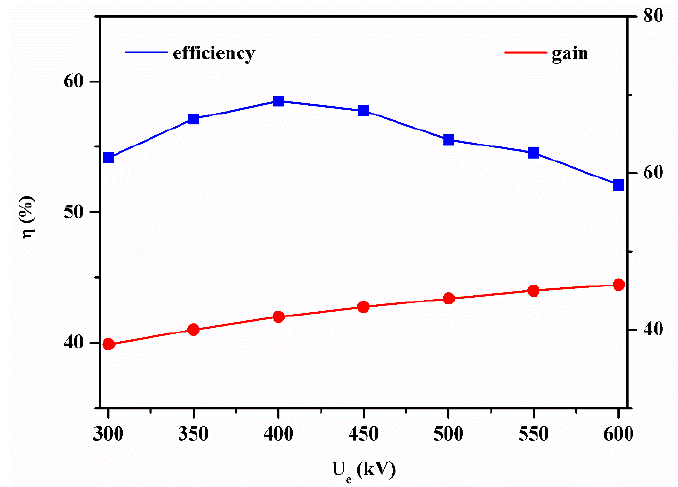
Figure 10. The first harmonic current distribution versus electron beam voltage and current.